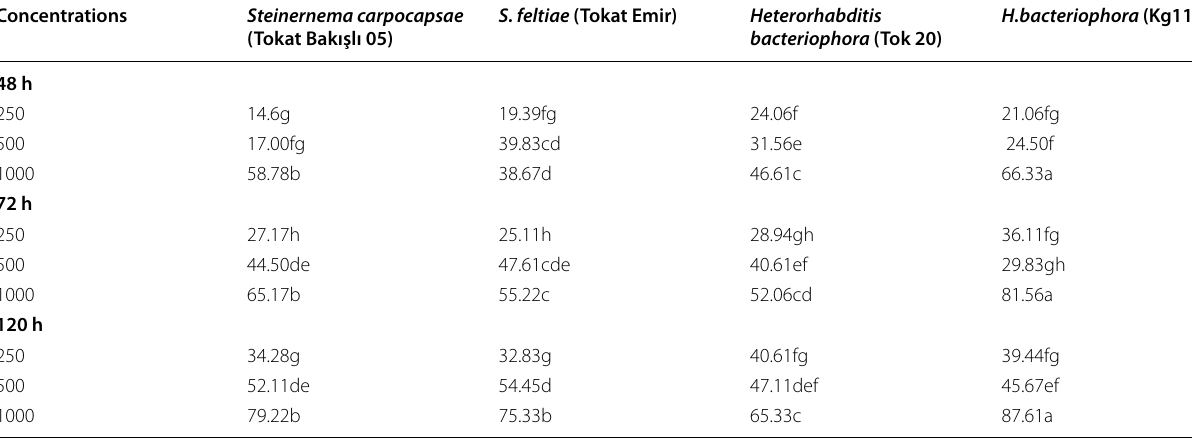
F 15.3 67, 77 and 108 for 48, 72, 120 h, respectively. P < 0.01